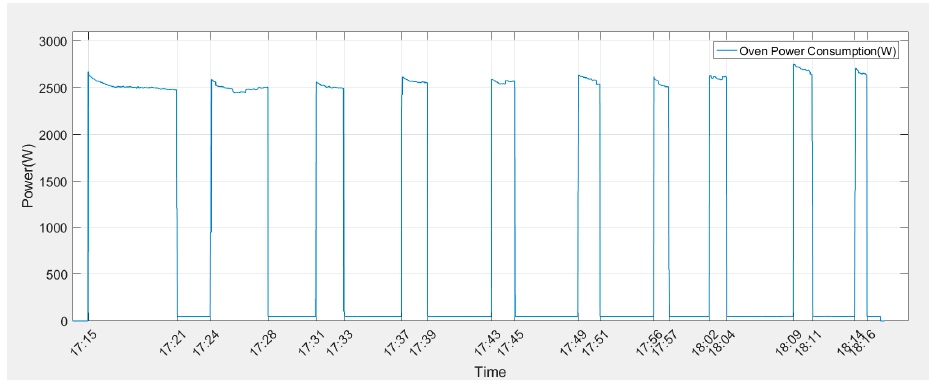
Figure 11. The power consumption curve of the oven for cooking at 180 °C temperature.